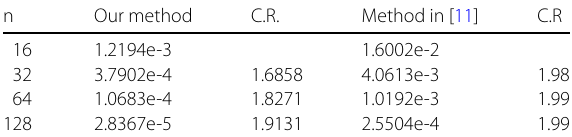
Table 1 E ( h ) of Example 1